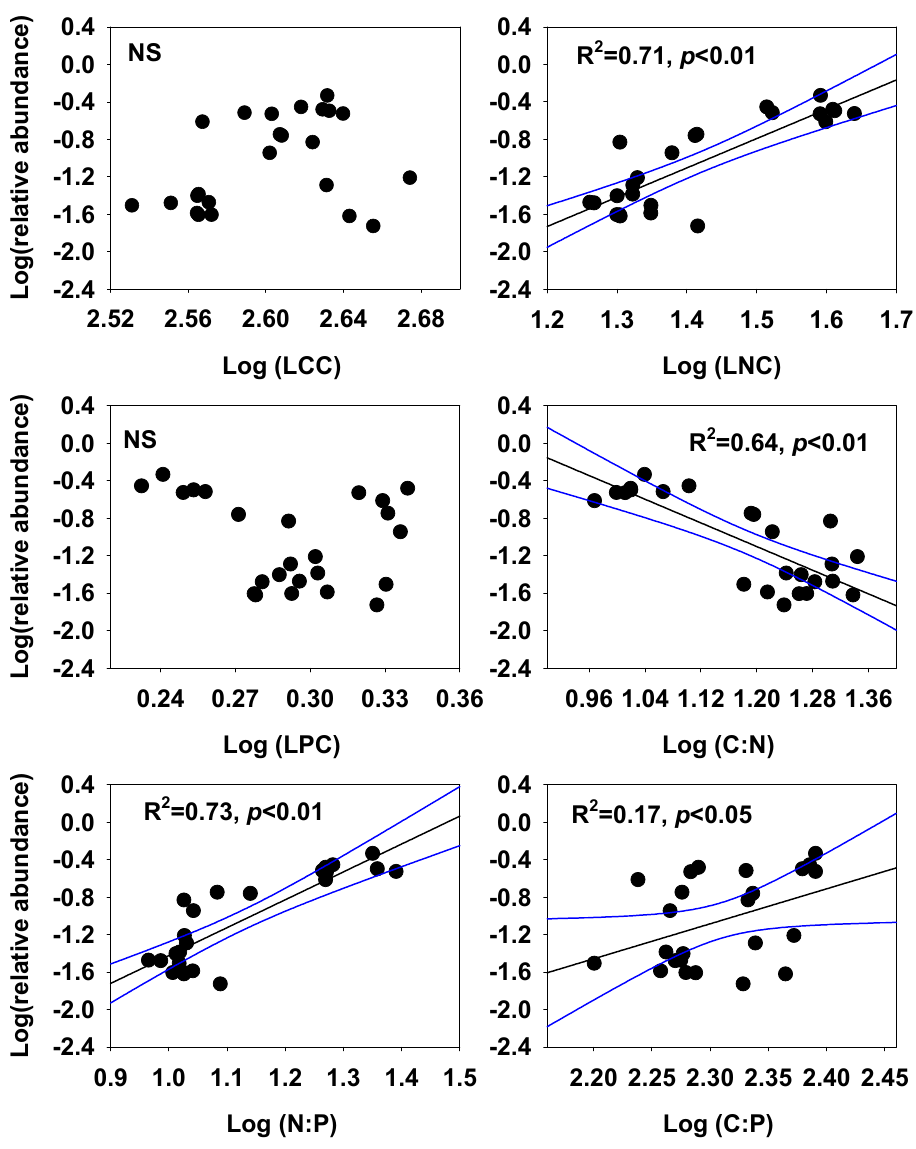
Figure 2. Relationships between species’ relative abundance and ecological stoichiometric traits among common species in all plots, irrespective of nitrogen addition. LCC, leaf carbon content; LNC, leaf nitrogen content; LPC, leaf phosphorus content.